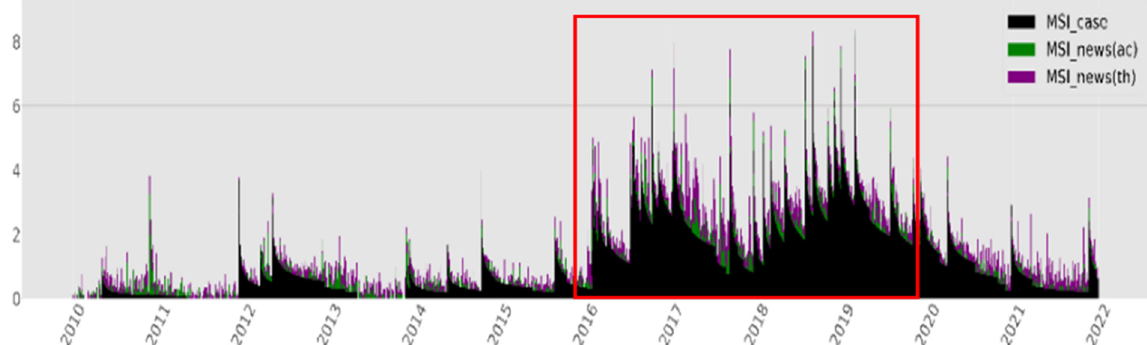
Figure 10. Military Security Index of China (‘10 ∼ ’21).